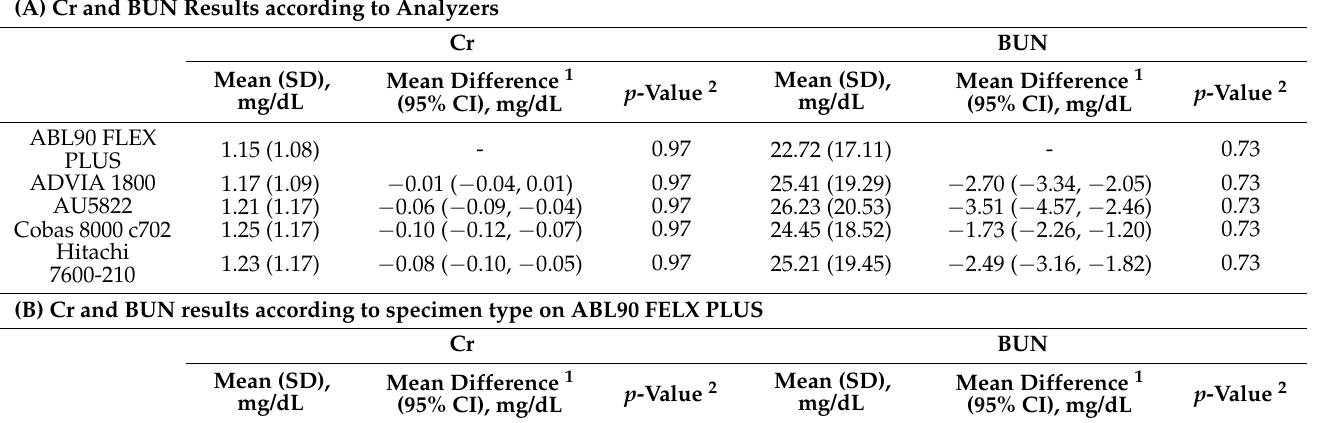
Table 1. The summary of the Cr and BUN results using the ABL90 FLEX PLUS compared to the four automated chemistry analyzers (A) and specimen types